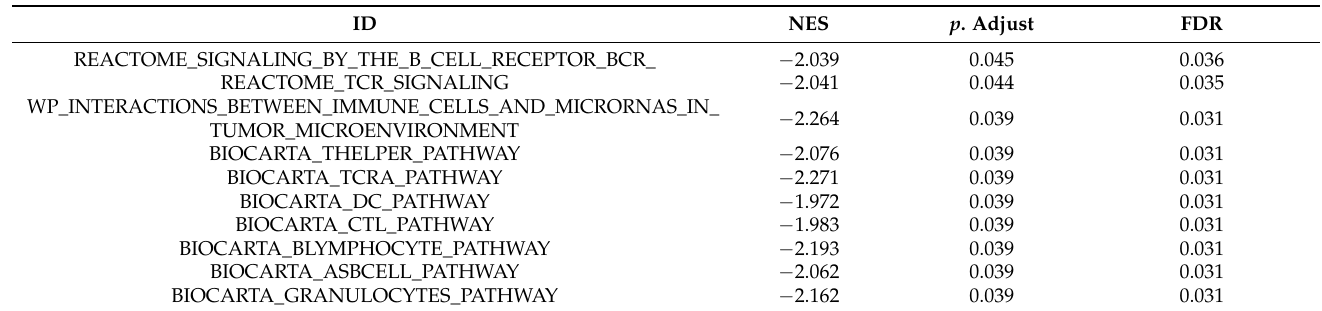
Table 4. Pathways, associated with immune cells, were demonstrated significantly differential enrichment between PTPRN high and low expression groups according to NES, FDR, and p